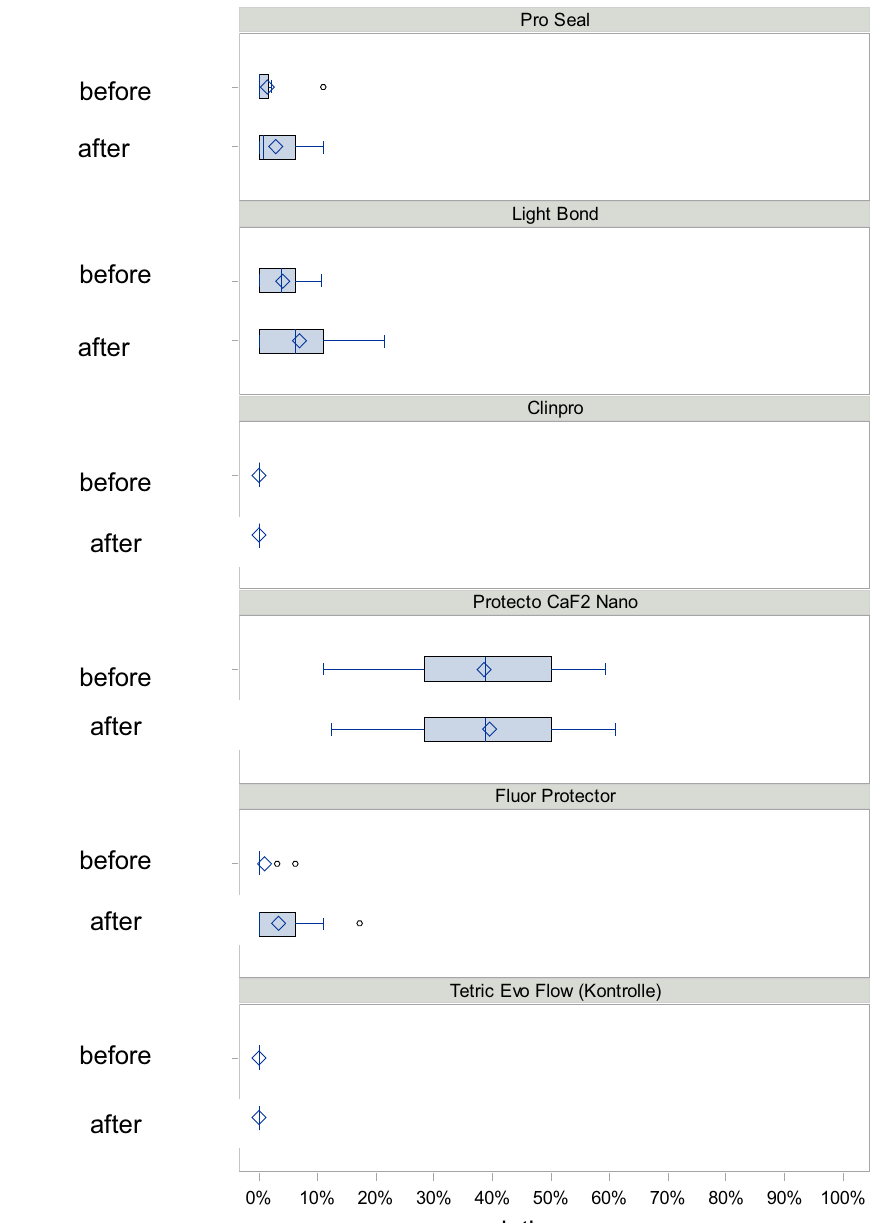
Figure 2. Boxplot diagram for the distribution of the relative score before and after the test under thermal